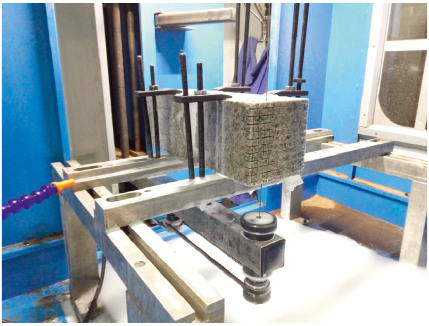
Figure 3: Rock sample processing.